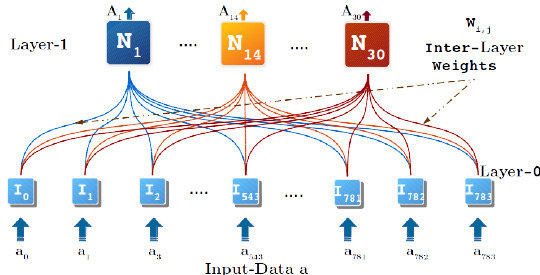
Figure 10. RAN model generated with MNIST dataset.